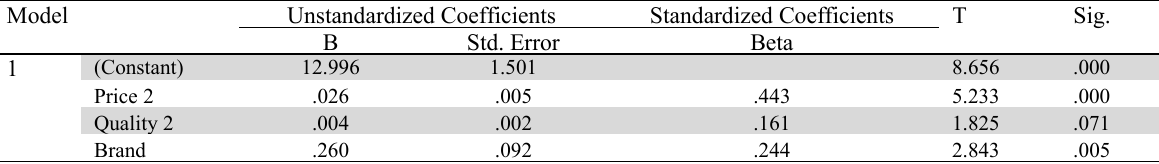
Model 8 Multiple Linear Regression Test Results (Coefficients a ) Model